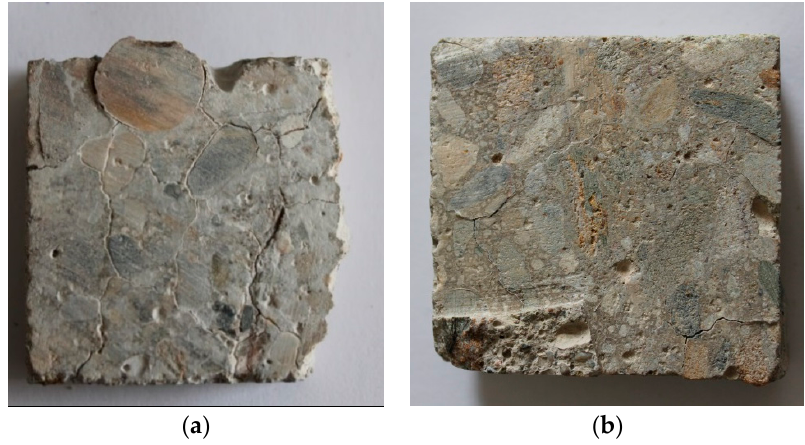
Figure 7. Samples ( a ) without and ( b ) with the addition of silica fume after the chemical exposure.